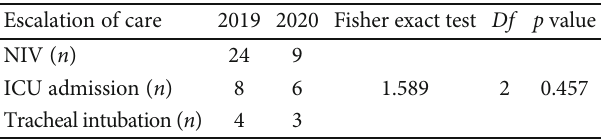
Table 3: Escalation of care of patients hospitalised with AECOPD (analysed using Fisher ’ s exact